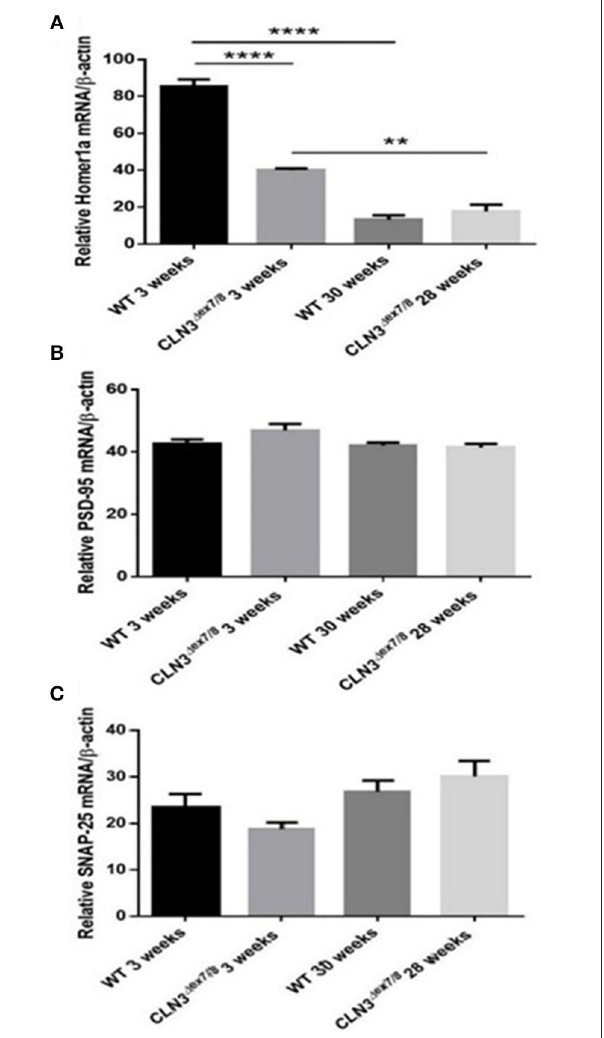
FIGURE 6 | Relative mRNA expression of post-synaptic protein Homer-1a (A) (** P < 0.01 and **** P < 0.0001), post-synaptic protein PSD-95 (B) and pre-synaptic protein SNAP-25 (C) in WT and Cln3 ∆ ex7/8 mouse brain at 3 and 28–30 weeks of age ( n = 3 in each group) as determined by qRT-PCR.